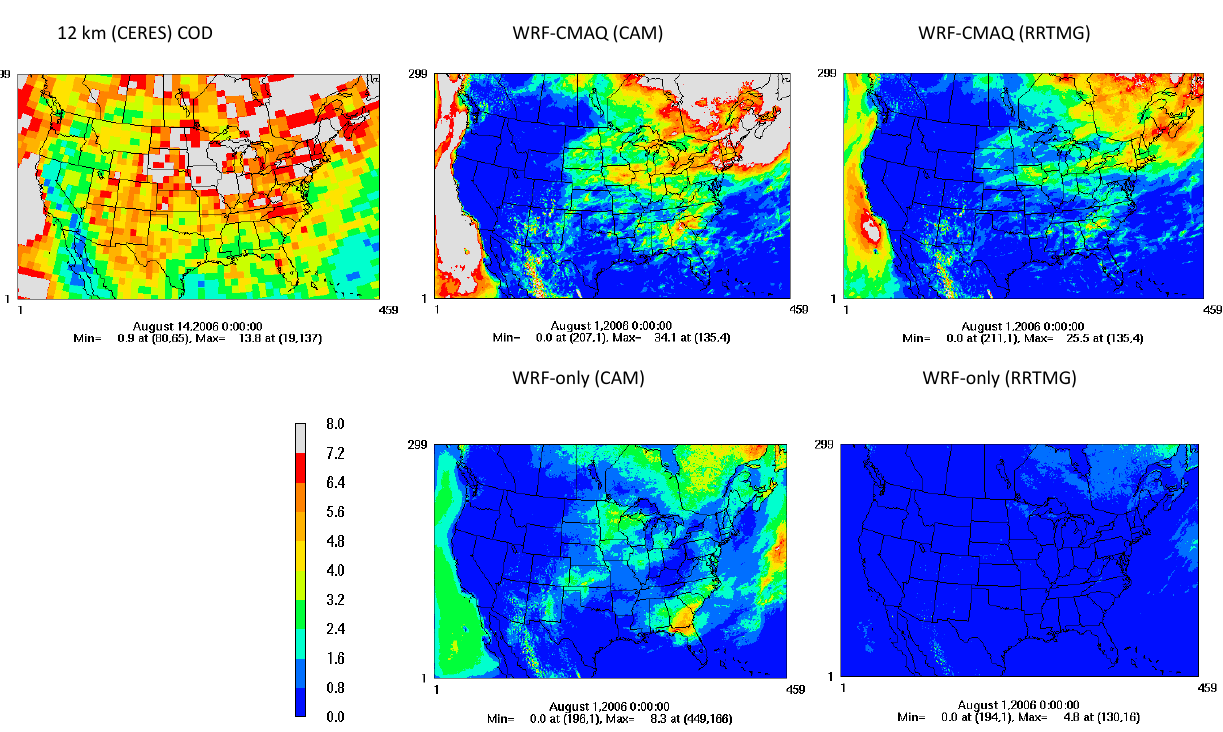
Figure 19. Same as Figure 9 but for COD for August of 2006